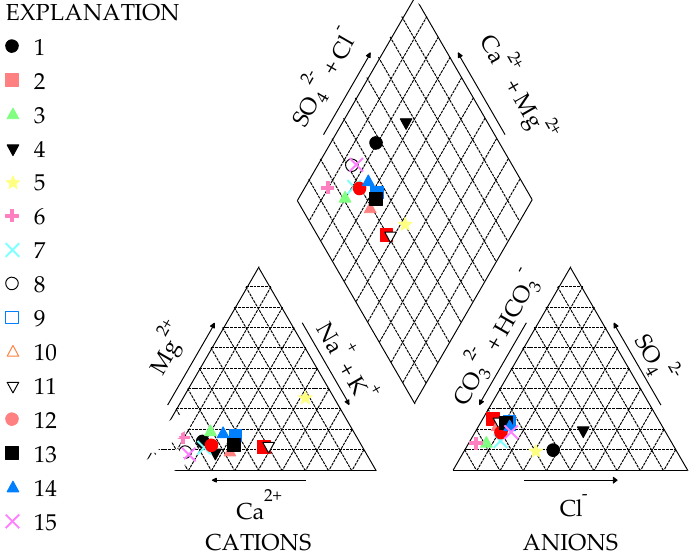
Figure 6. Piper plot applied for water samples